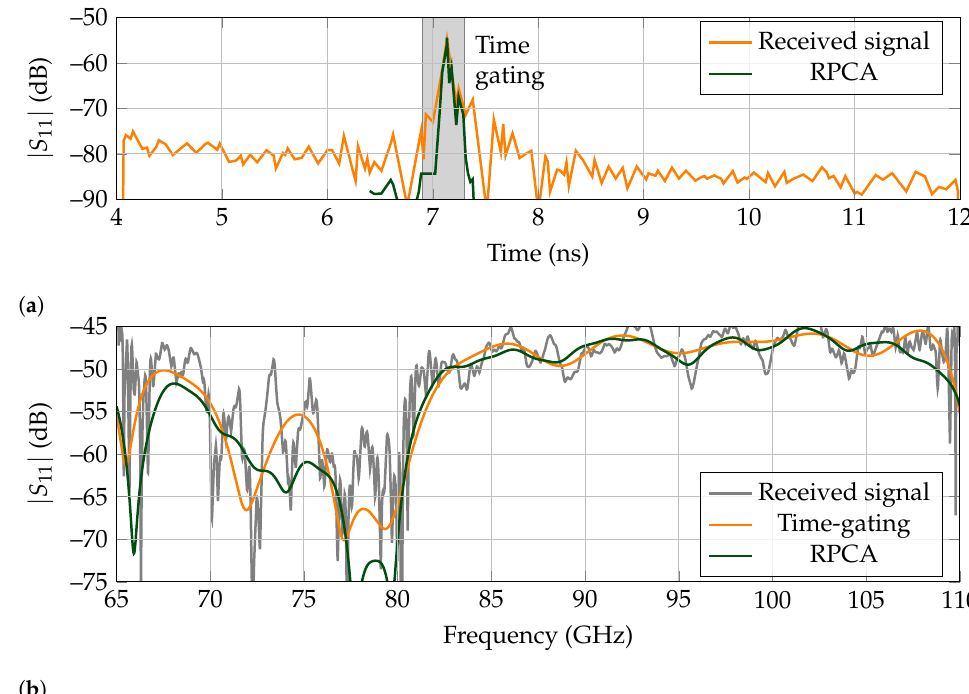
Figure 8. Backscattered results for a low-Q landmark for measurements performed in a corner of the laboratory. ( a ) Time response. Time gating is performed between 6.9 ns to 7.3 ns. ( b ) Frequency re-